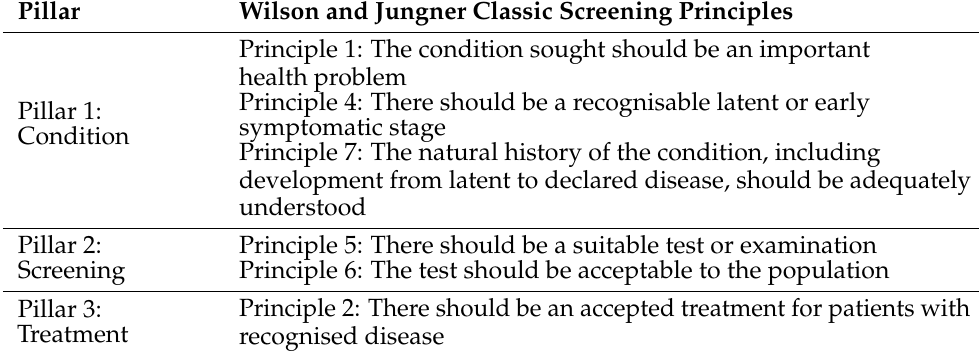
Table 2. Three pillars of novel